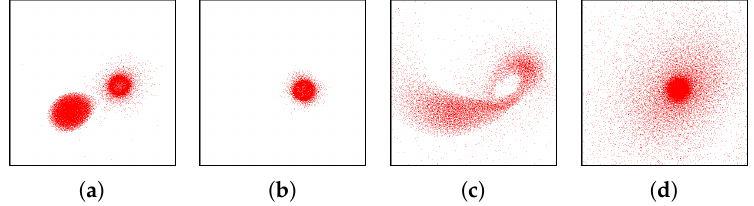
Figure 8. Linked views of selections in Figure 7 in physical domain. Selection ( a ) represents two separated stars. Selection ( b ) shows that the shell of the core of one star is in the same condition, while selection ( c ) shows that the matter of the other star is absorbed by the first one. Selection ( d ) shows the merged structure. Please note that the representation of the heavier star seems smaller, as it represents data points with higher internal energy and therefore is only a